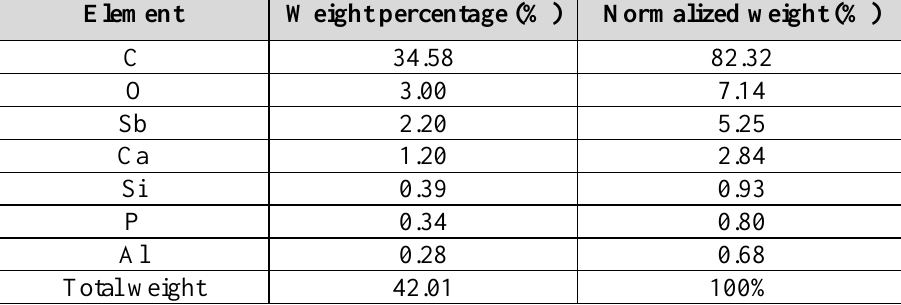
Table 4: The chemical composition of the natural leaves (citrus